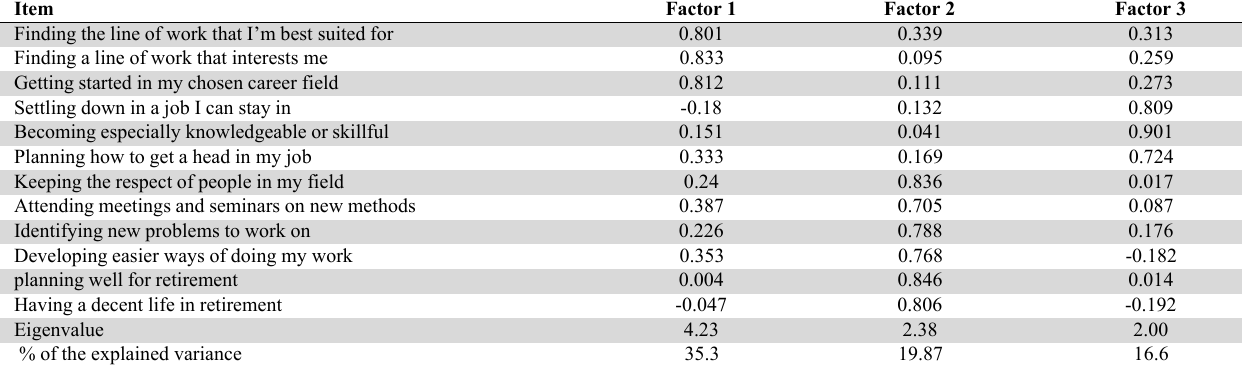
PCA. Career stage (after oblique